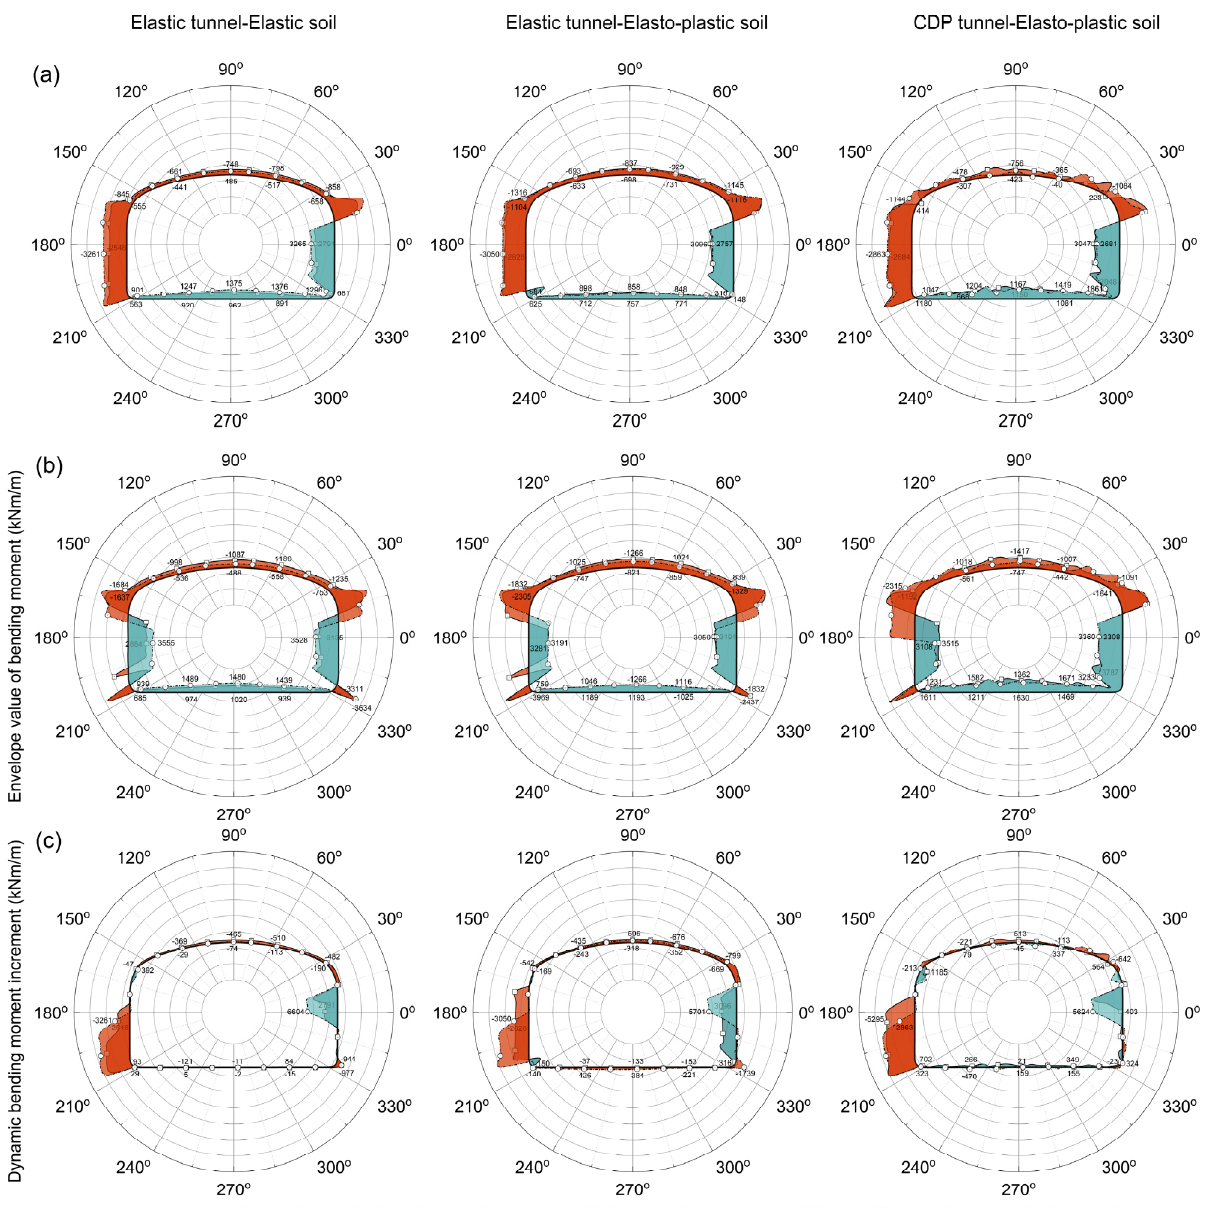
Figure 16. Bending moment distributions computed along the perimeter of the tunnel for EQ1: ( a ) simultaneous value of bending moment, ( b ) envelope value of bending moment, ( c ) dynamic bending moment increment of the maximum positive (+X) shear deformation.